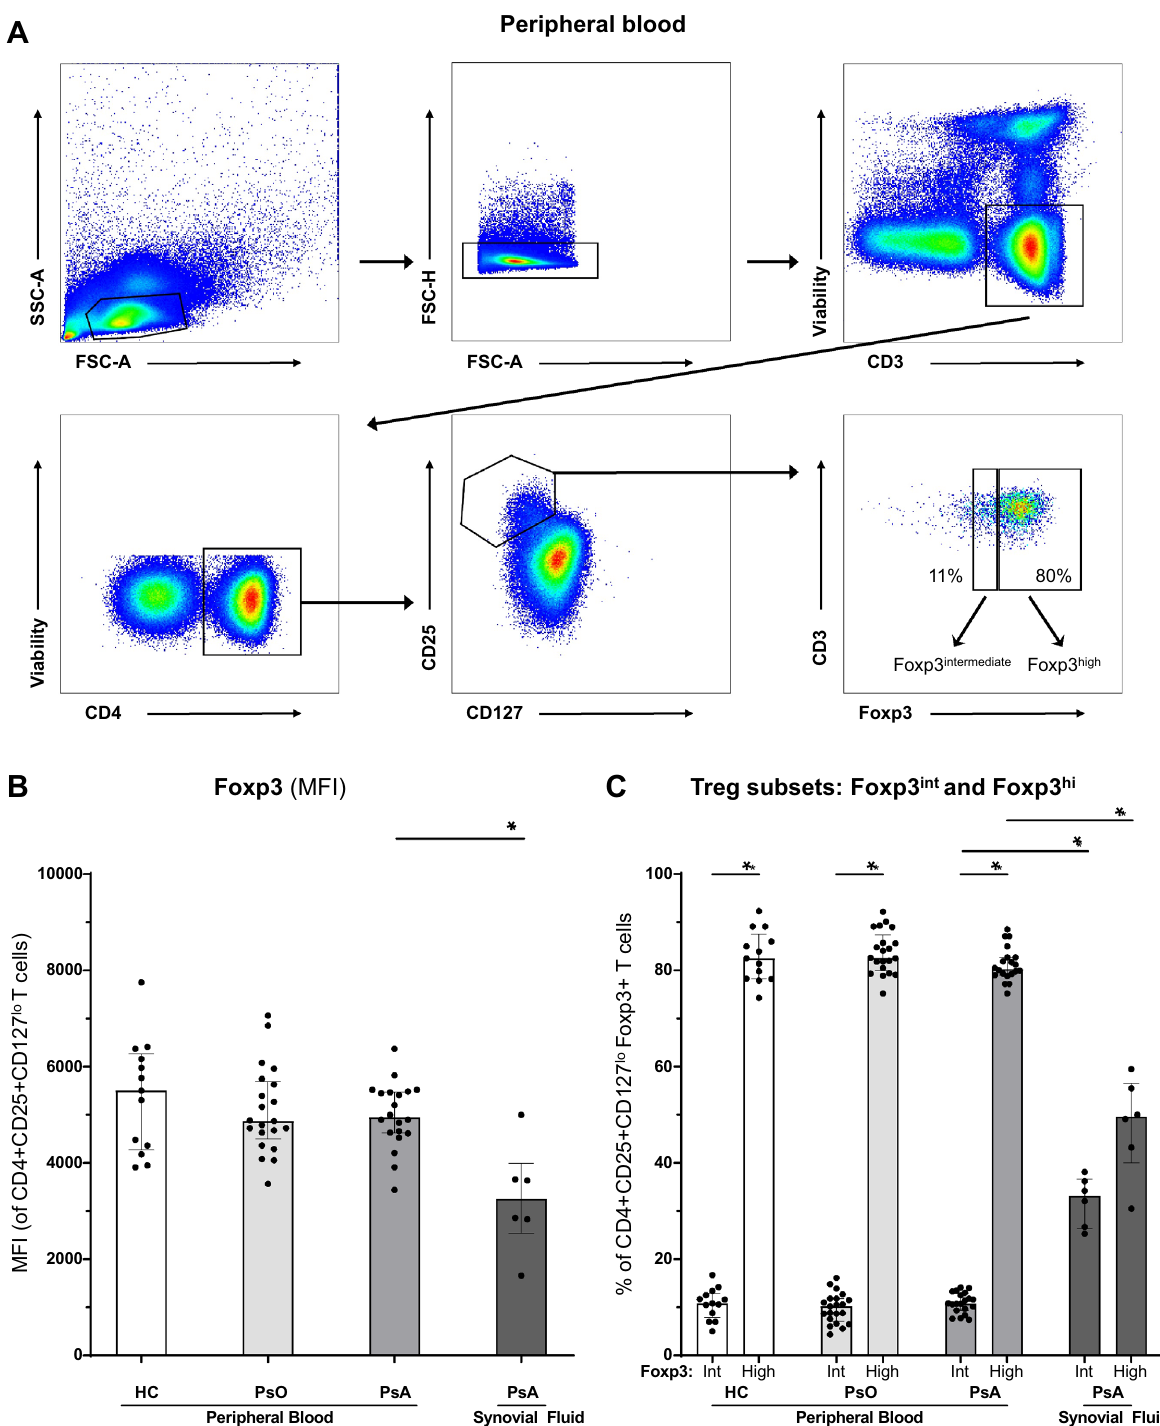
Figure 1. Increase of Tregs with intermediate Foxp3 expression in inflamed PsA joints. Flow cytometry analysis of Foxp3 expression by CD4 + CD25 + CD127 lo T cells derived from peripheral blood of HC (n = 13), psoriasis patients (n = 21) and PsA patients (n = 20), and from synovial fluid of PsA patients (n = 6). Bar graphs: symbols represent individual subjects; bars show median with interquartile range; * P value < 0.05 (PsA synovial fluid only compared with PsA peripheral blood). ( A ) Gating strategy for CD4 + CD25 + CD127 lo Foxp3 + Tregs. We differentiated between Tregs with intermediate and high expression of Foxp3 (Foxp3 int and Foxp3 hi , respectively). Percentages in dot plots represent median of peripheral blood-derived Tregs in PsA. ( B ) Foxp3 expression by CD4 + CD25 + CD127 lo T cells. ( C ) Proportion of Foxp3 int and Foxp3 hi Tregs of CD4 + CD25 + CD127 lo T cells. Foxp3 int / hi : forkhead box P3 expression intermediate / high; FSC-A: forward scatter area; FSC-H: forward scatter height; HC: healthy control; MFI: median fluorescent intensity; PsA: psoriatic arthritis; PsO: psoriasis; SSC-A: sideward scatter area; Treg: T regulatory